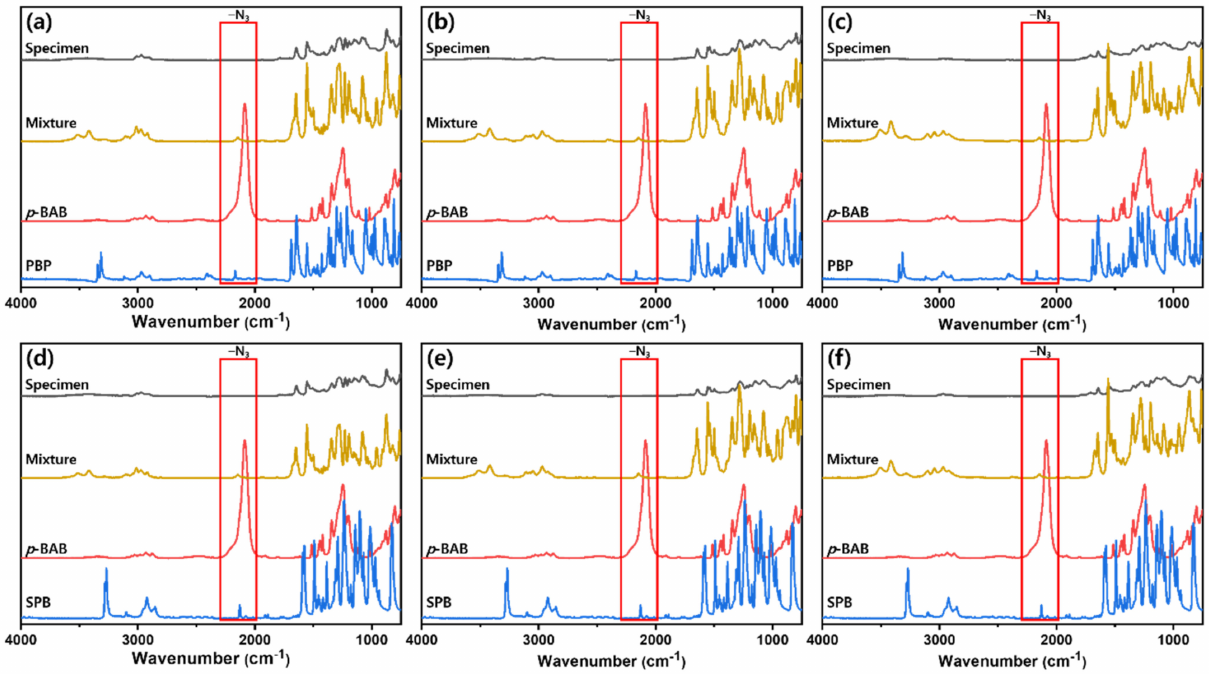
Figure 10. FT-IR spectra of specimen, mixture, p-BAB, and PBP (or SPB): ( a ) DGEBA/PTK; ( b ) DGEBF/PTK; ( c ) TGAP/PTK; ( d ) DGEBA/PTS; ( e ) DGEBF/PTS and ( f )